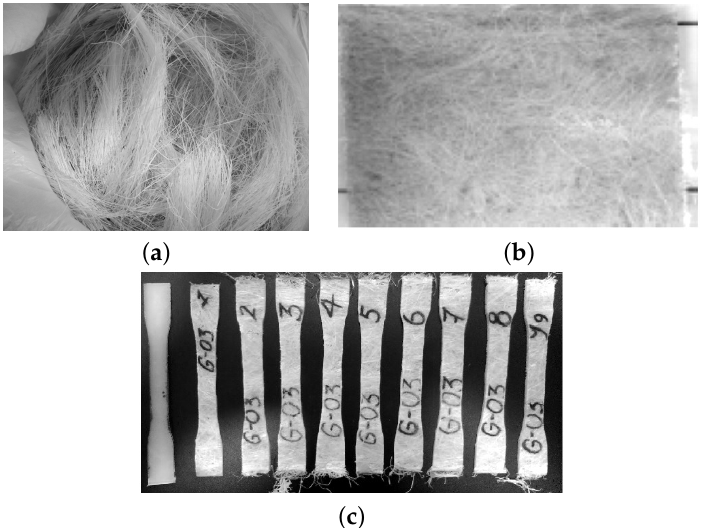
Figure 3. ( a ) Dry henequen fibers. ( b ) Composite plate. ( c ) Typical traction samples of fiber-reinforced